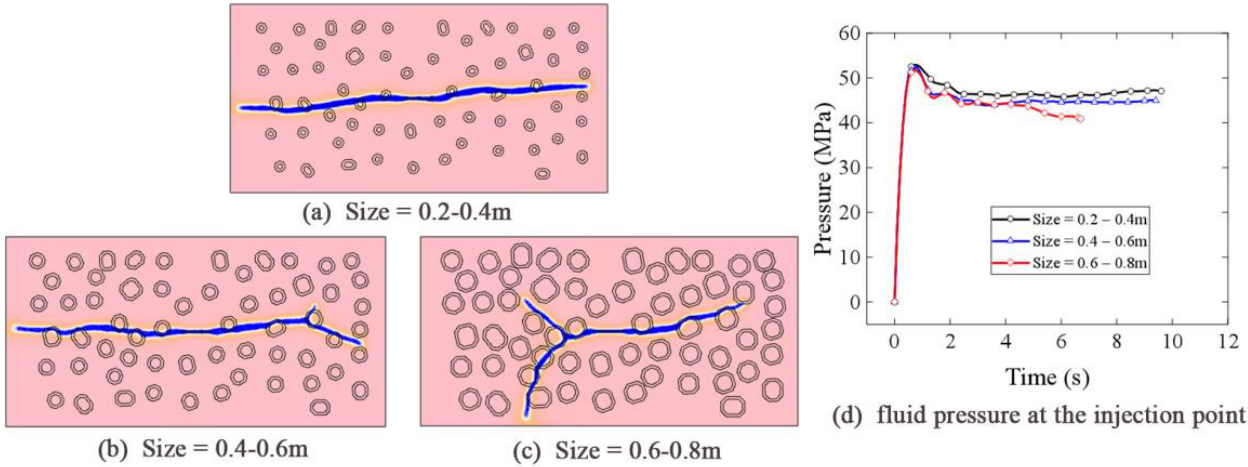
Figure 14. Fracture geometries and fluid pressure at the injection point for different sizes of gravels.